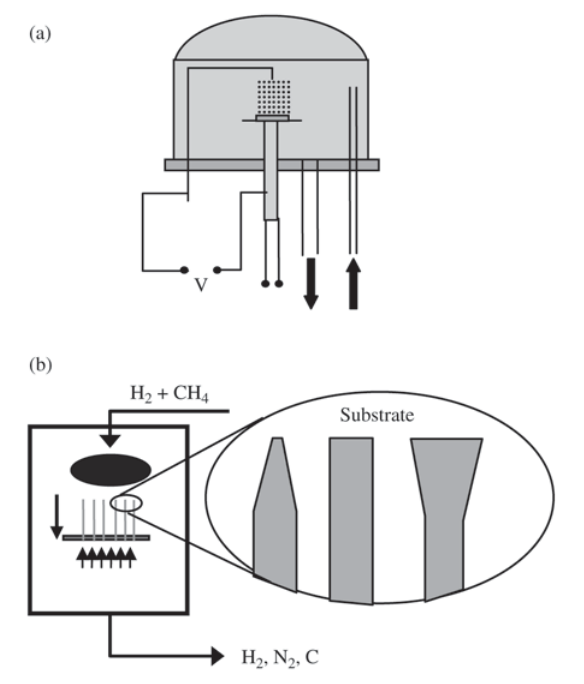
Figure 1. Experimental diagrams: a) DC discharge; b) diamond growth